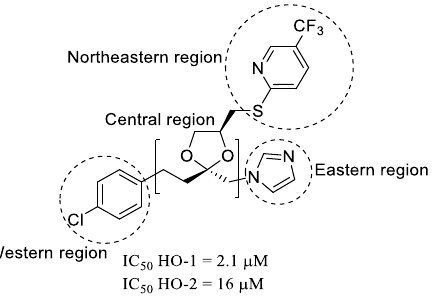
Figure 1. Chemical structure and IC 50 values of representative HO-1 and HO-2 inhibitors (QC-80).